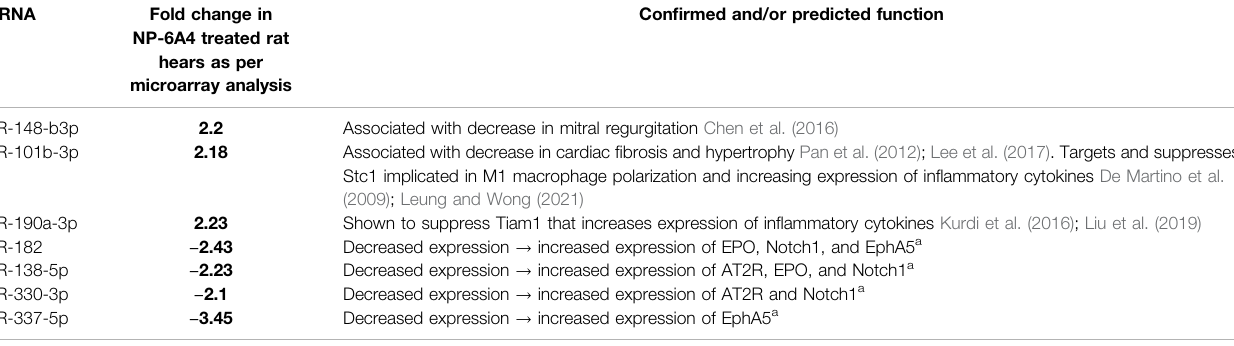
TABLE 3 | Differentially expressed cardiac miRNAs of ZO rats in response to NP-6A4 treatment may contribute to mitigating cardiac damage, suppressing in fl ammatory cytokines and regulating expression of AT2R, EPO and Notch1. miRNA Fold change in NP-6A4 treated rat hears as per microarray analysis